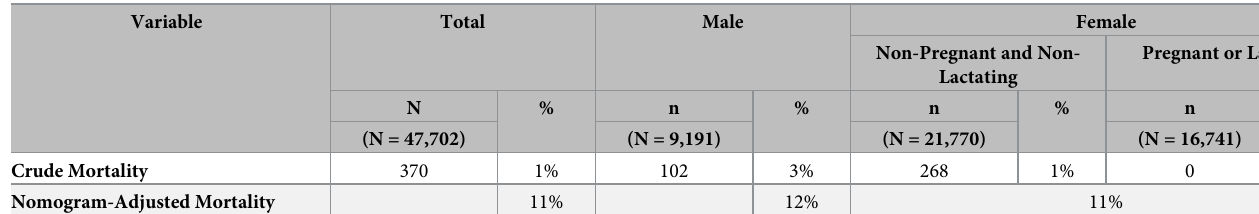
Table 5. Mortality